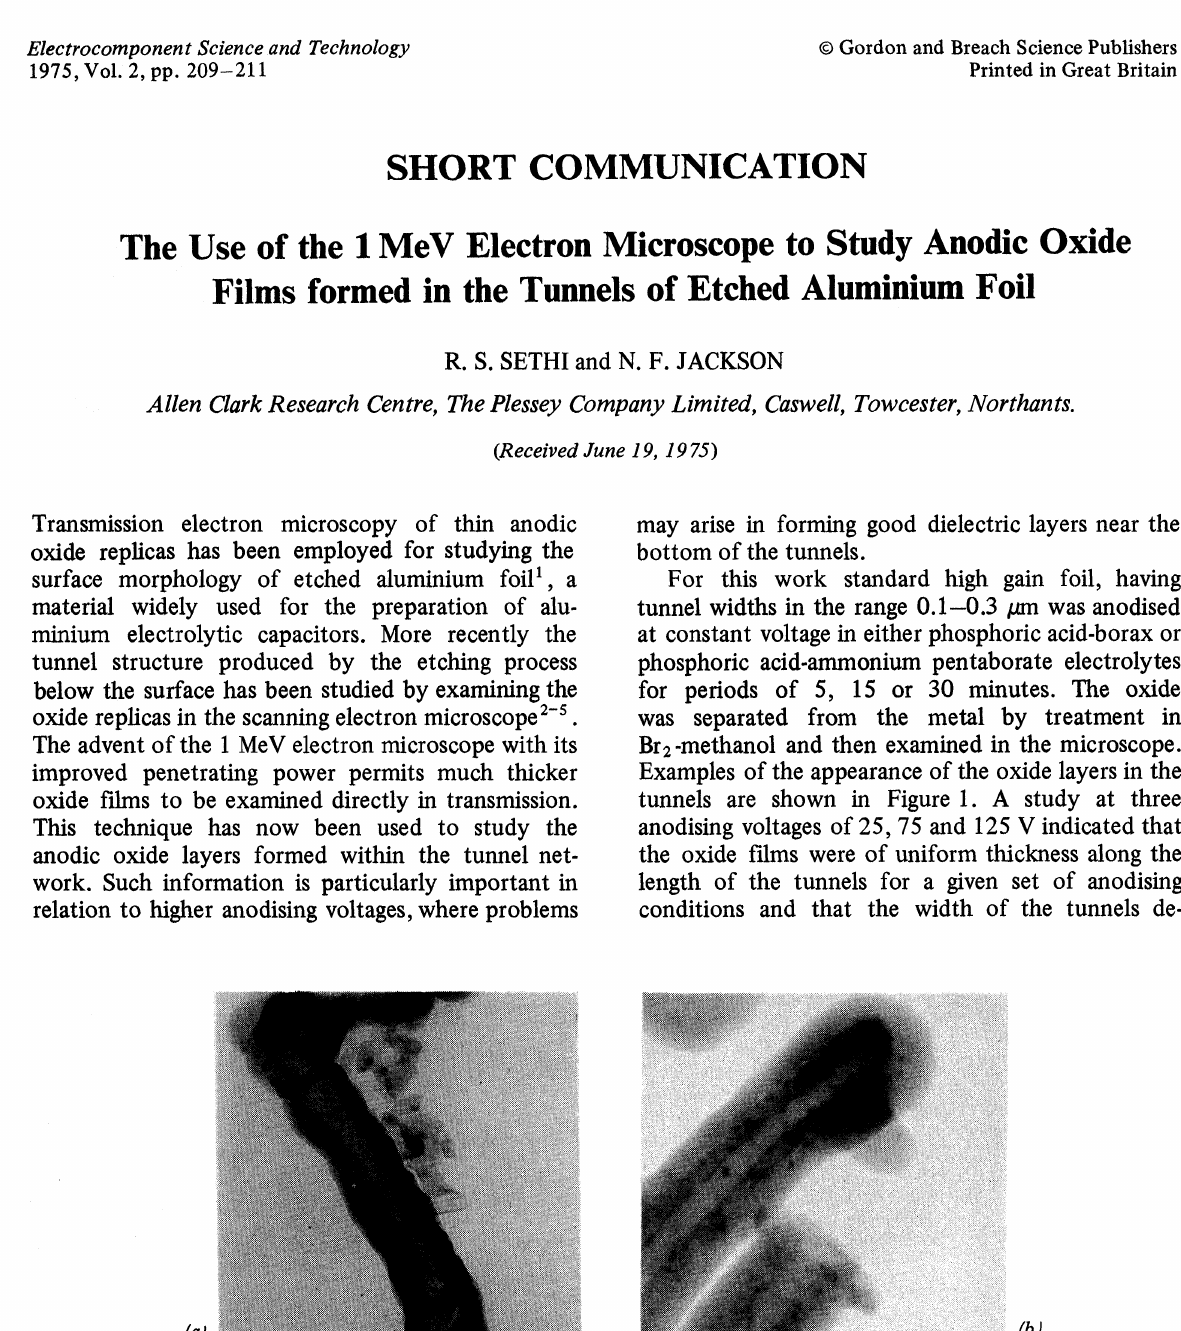
Transmission micrographs of oxide films Iormed in the tunnels of etched aluminium foil anodised in H3PO,-borax electrolyte (pH 5.5) at 98C for 30 minutes: (a) 25 V, (b) 125